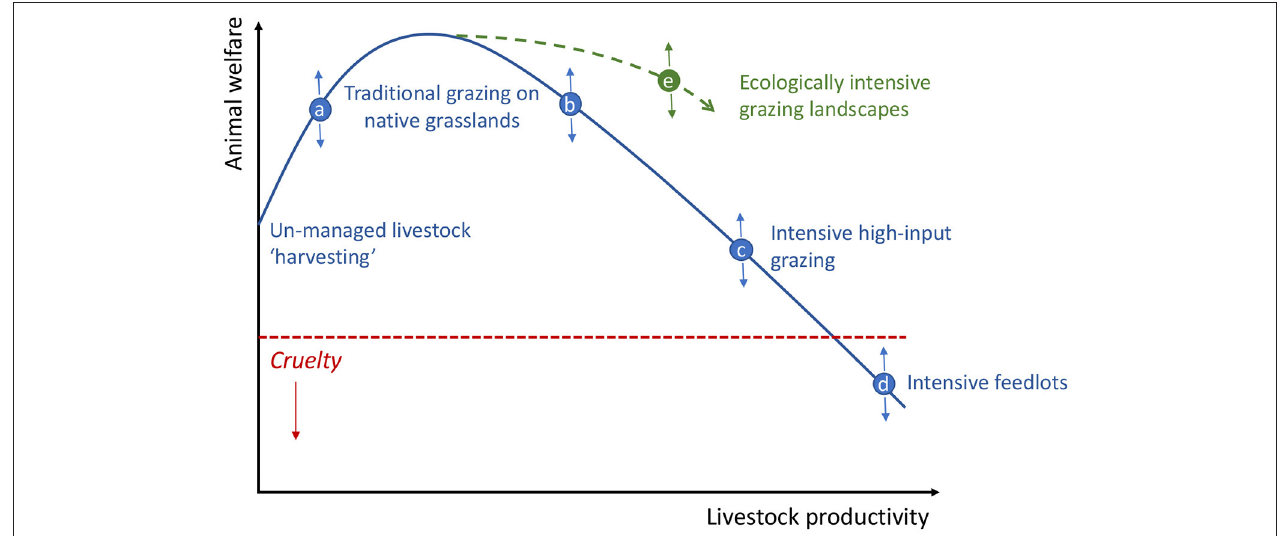
FIGURE 2 | A representation of the relationship between (perceived) animal welfare and livestock productivity following the conceptual mode of McInerney (2004) to depict the various beef production systems that can be found in the Rio de la Plata Grassland Biome. Red dotted line represents a minimum welfare level below which we may speak of cruelty towards domestic animals. Points a and b indicate respectively the approximate situation of traditional family and entrepreneurial graze-based livestock systems in the region. Vertical arrows indicate variation in terms of animal welfare within each type of system. The green dashed line represents the scope of ecologically intensive razing landscapes in terms of increasing productivity while minimising the trade-offs with animal welfare.